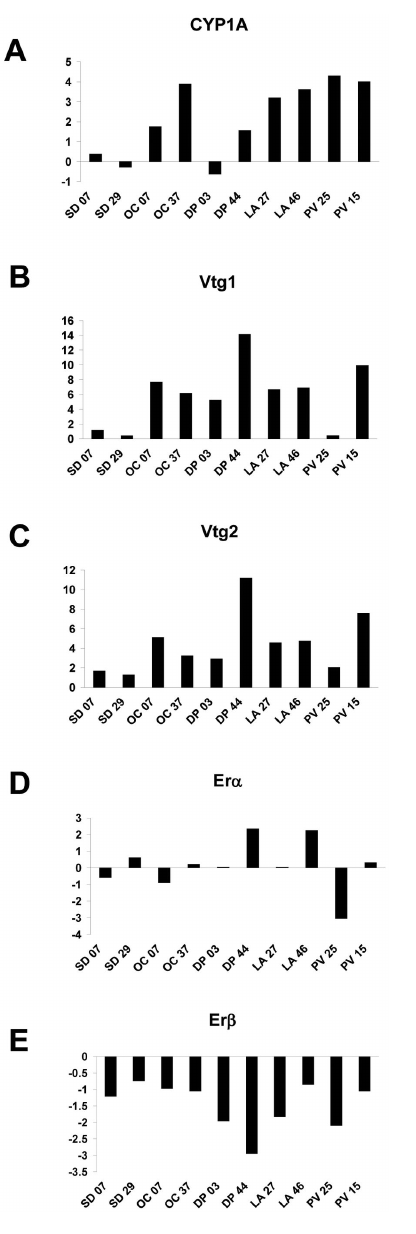
Figure 4. Q-PCR validation of Multi-Species Endocrine Microarray. Multi-species SYBR green Q-PCR validation of multi-species microarray for (A) CYP3A (B) Vit1 (C) Vit2 (D) ESR1/ ERα (E) ESR2/ ERβ specific transcripts. GAPDH - normalized fold changes (based on triplicate measurements) of gene expression in turbot liver from selected impacted sites with respect to reference fish are presented. Each fold change was derived from the mean log ratio between each fish and a 2 reference derived from two control fish. Vit1 and Vit2 transcripts were strongly up-regulated in all fish. ERα was down-regulated in one fish and up-regulated in two others relative to control fish. ERβ was down-regulated in all fish examined relative to control fish. CYP3A was up-regulated in eight and down-regulated in two fish.